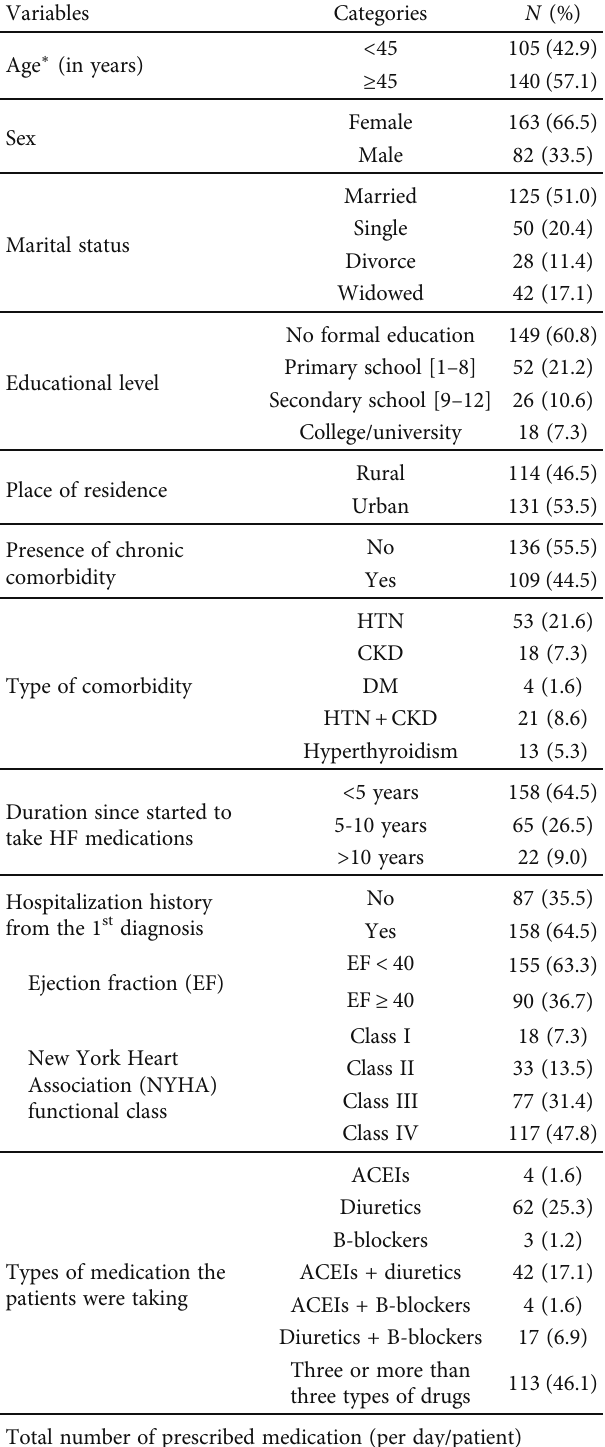
Table 1: Sociodemographic and clinical characteristics of HF patients at the University of Gondar